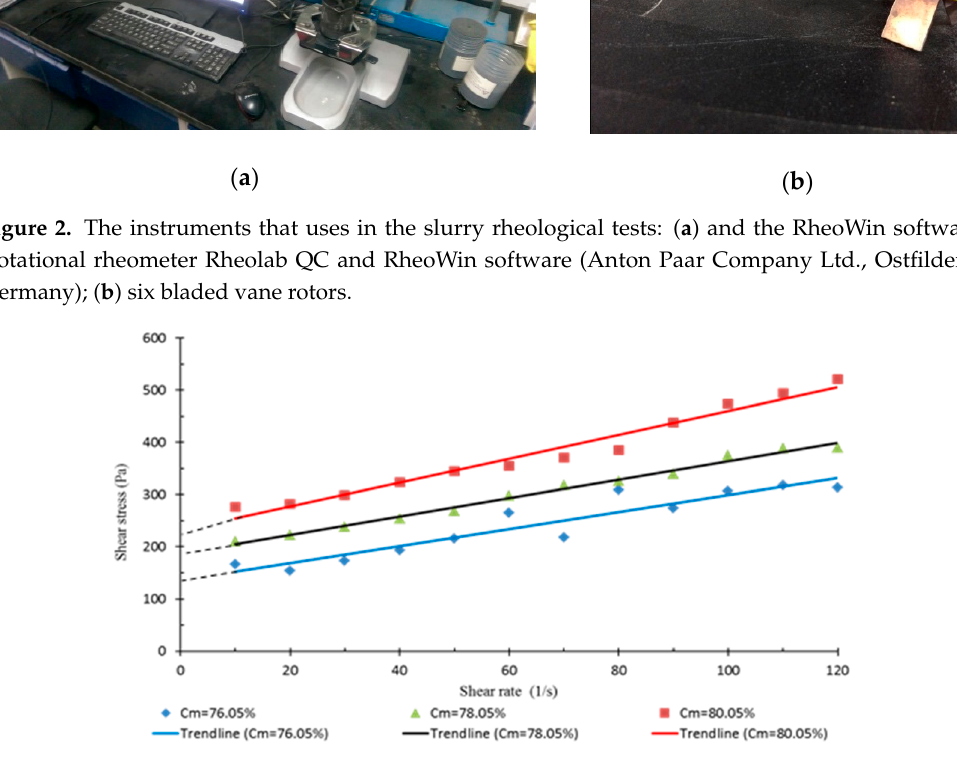
Figure 2. The instruments that uses in the slurry rheological tests: ( a ) ) and the RheoWin software ( Rotational rheometer Rheolab QC and RheoWin software (Anton Paar Company Ltd, Ostfildern, Germany); ( b ) six bladed vane rotors.